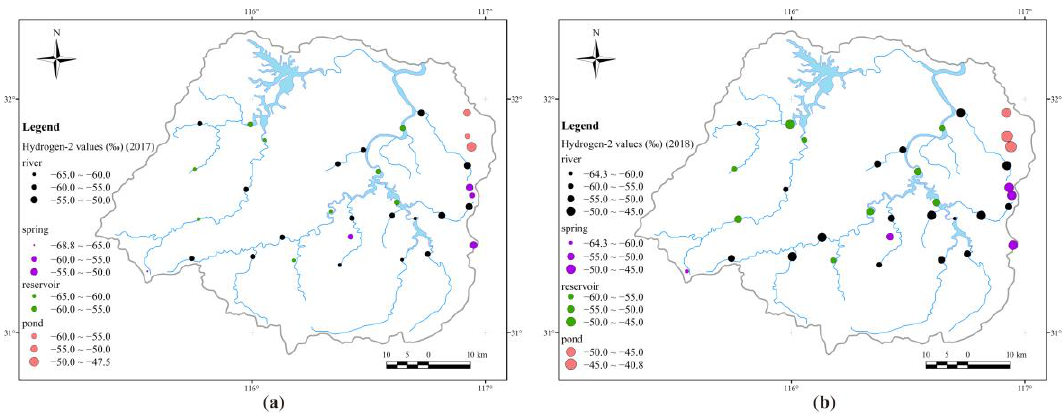
Figure 5. Spatial distribution of δ 2 H values in the Upper Pi River basin in (a) 2017 and (b) 2018.